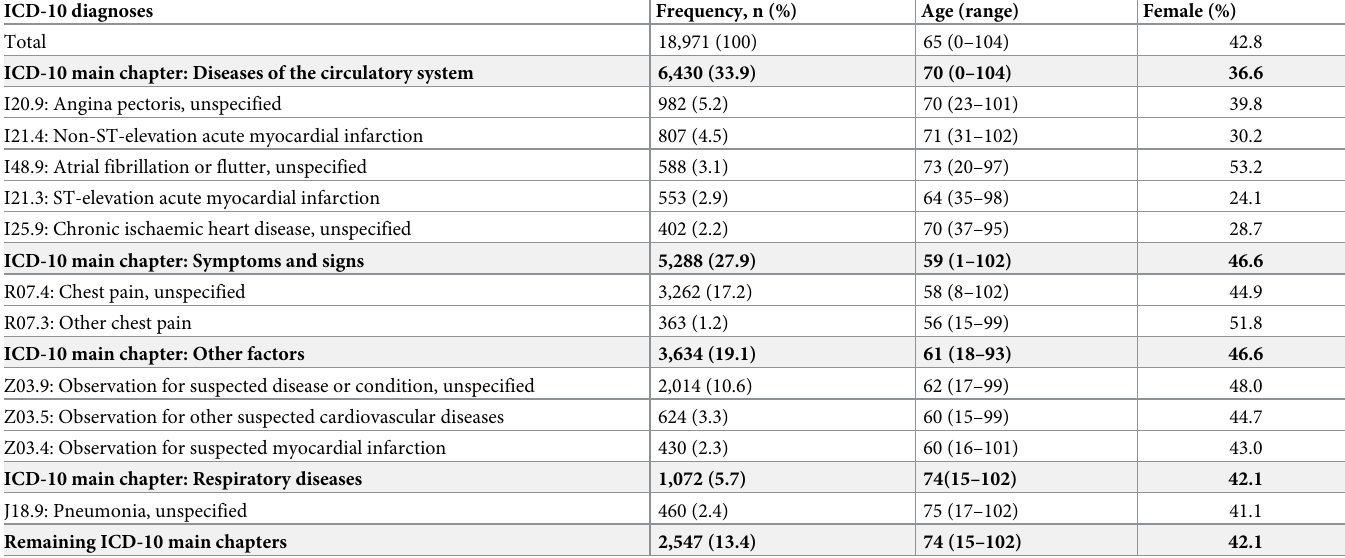
Table 1. Patient characteristics within the ten most frequent specific hospital diagnoses and corresponding main diagnostic chapters (ICD-10) following 1-1-2 emergency calls with chief symptom of chest pain. ICD-10 diagnoses